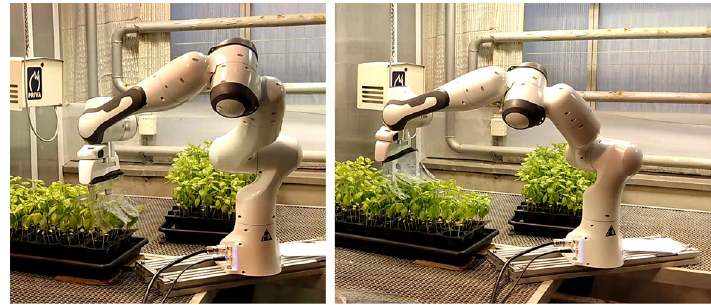
Figure 5. Two types of “robot stroking” motions: dipping (left) and plant-top stroking (right).